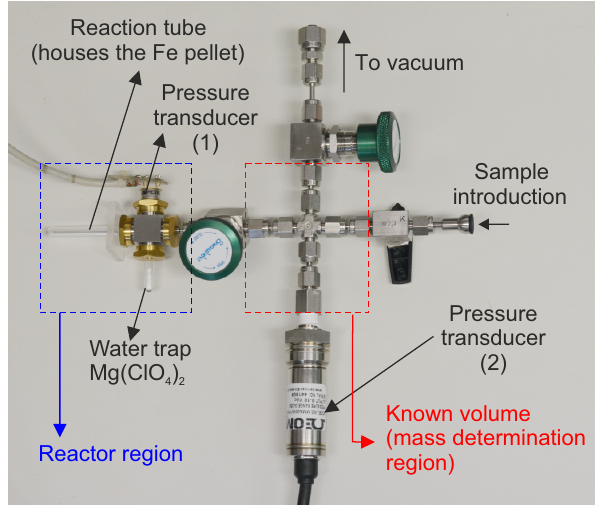
Figure 3. Newly designed reactor ( ≈ 1.5mL, blue box) for prepa- ration of ultra-small samples (3–50µgC) for AMS measurements. Each section of the stratospheric air subsampler contains ≈ 35µg CO 2 sample that is reduced to graphite ( ≈ 9.6µgC) on porous iron pellets at 500 ◦ C in the presence of hydrogen ( ≈ 2.2 × partial pres- sure of CO 2 ) . The mass determination section, comprising a known volume, is used to determine the mass of the reference materials and the samples based on pressure measured at pressure transducer (no. 2). Pressure transducer (no. 1) is used to monitor the progress of the graphitization